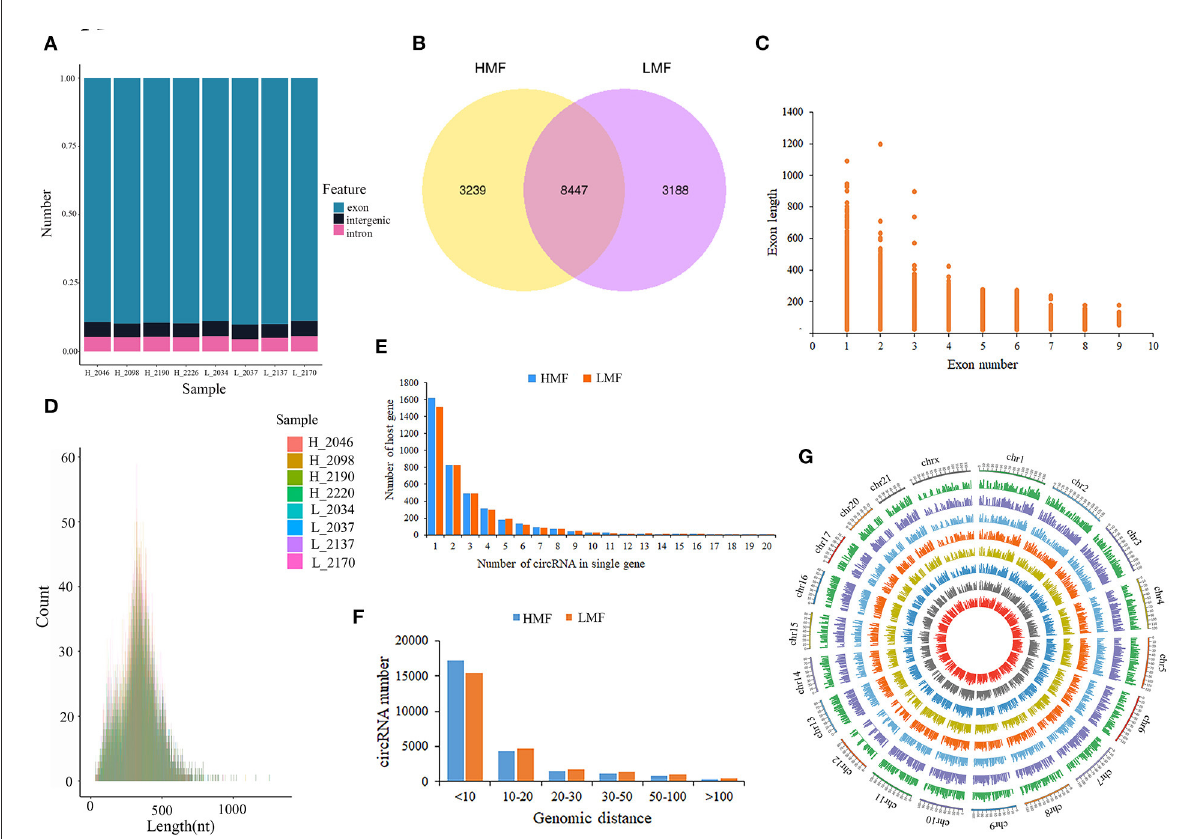
FIGURE1 Characterization of circRNAs in mammary epithelial cells of cows. (A) Statistics of circRNAs sources. (B) Distribution of circRNAs in mammary epithelial cells of cows with high and low milk fat percentage. (C,D) Exon lengths of circRNAs. (E) Number of circRNAs produced by the same gene. (F) Genomic distance of circRNA reverse splice sites. (G) Chromosomal distribution of